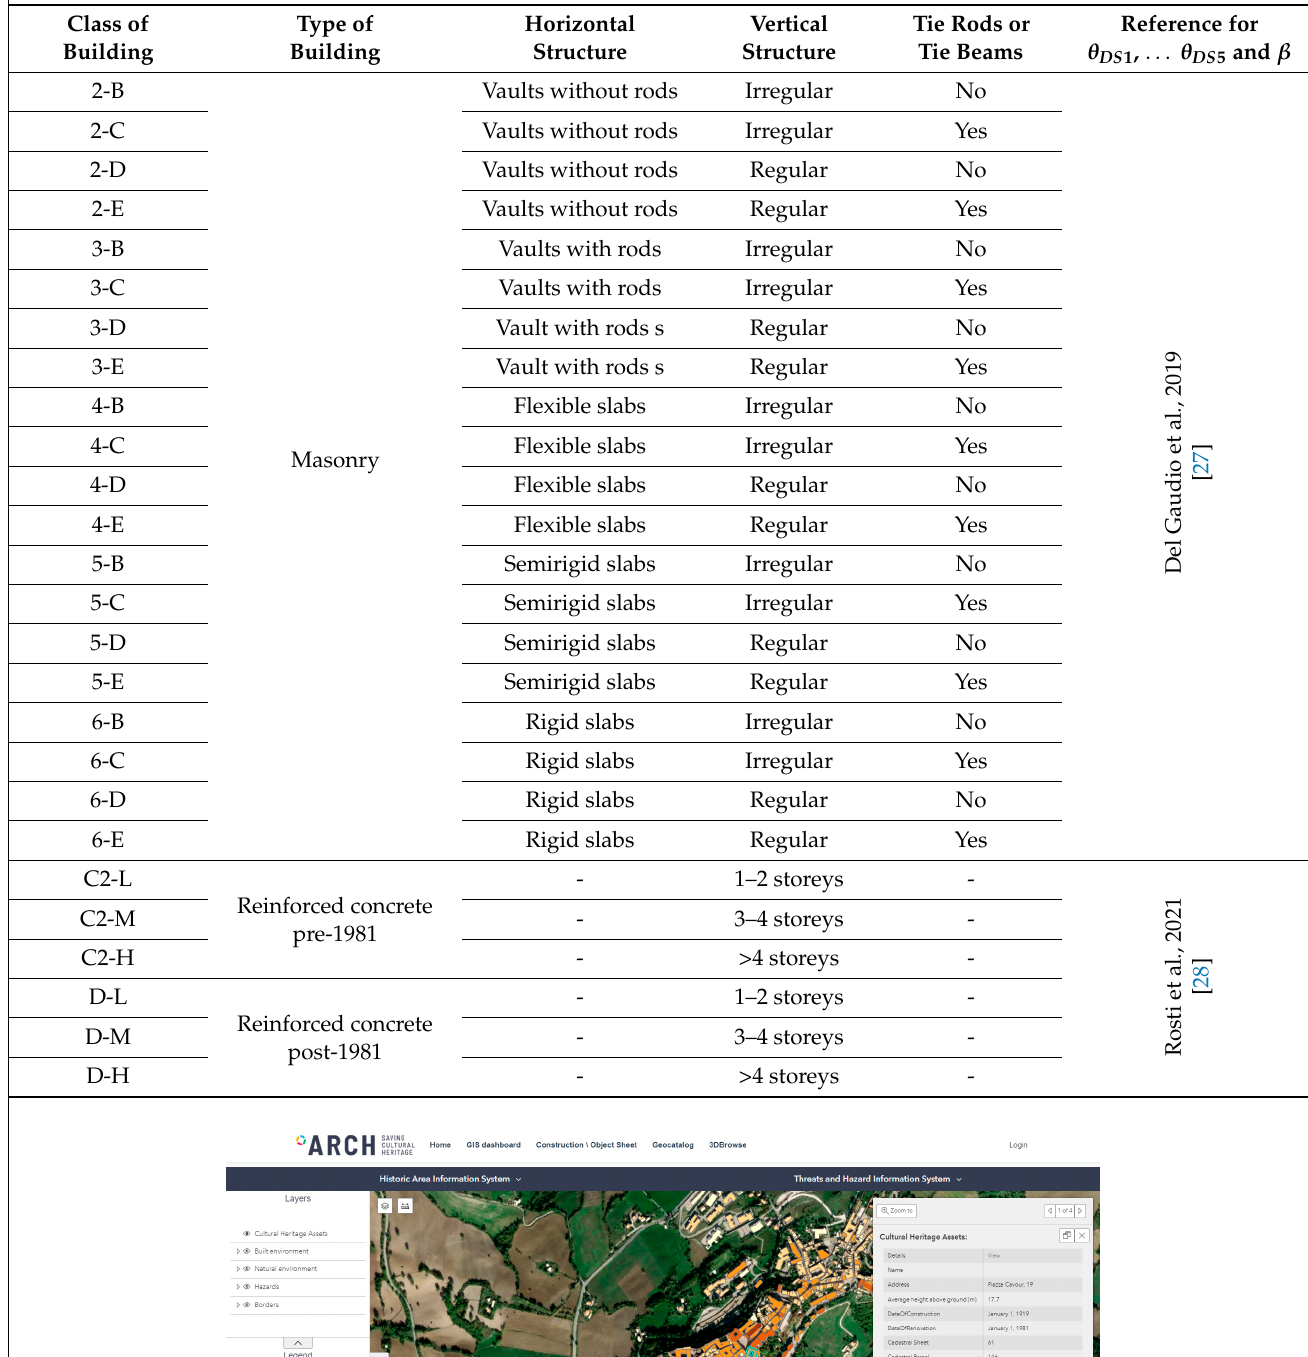
Table 1. Correspondence between building classes and references for values of logarithmic means θ DSk and logarithmic standard deviation β used in Equation (1), which are currently implemented in the system.